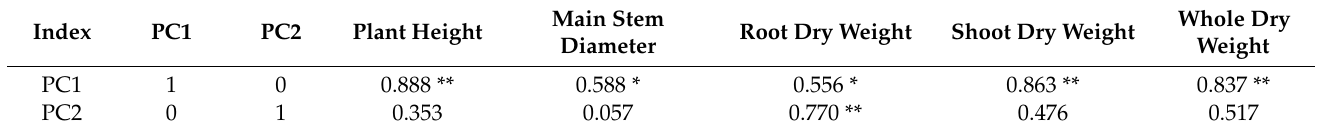
Table 5. Correlation coefficients between the principal components and growth